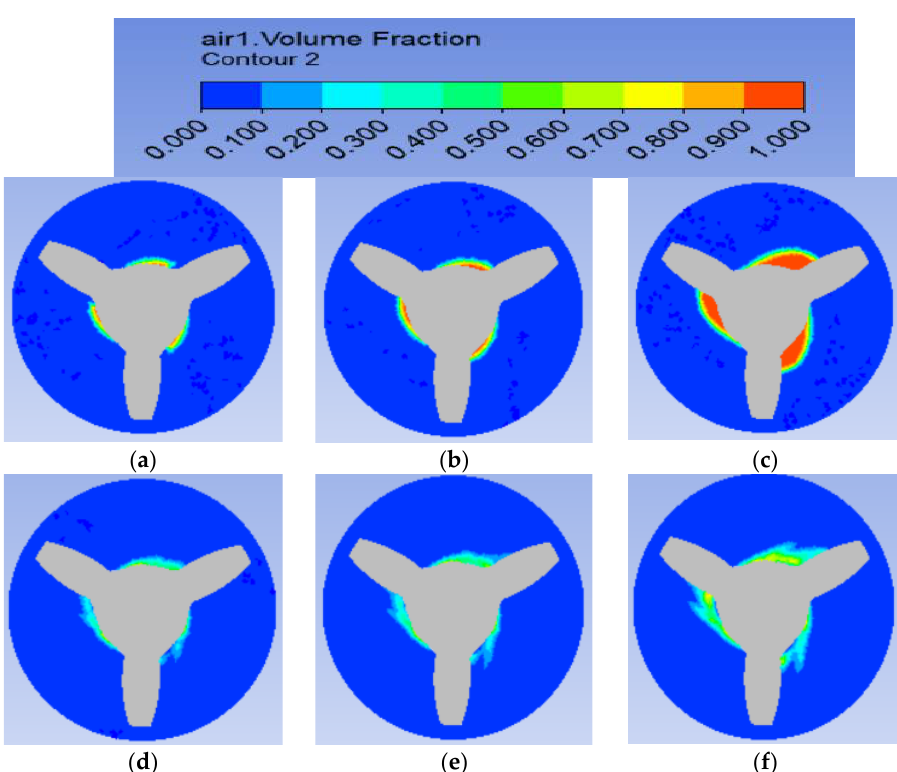
Figure 8. Cross-sectional cloud diagram of the liquid water vapor volume fraction of two different Zwart models at three temperatures. ( a ) Iso-Zwart T = 298 K; ( b ) Iso-Zwart T = 320 K; ( c ) Iso-Zwart T = 350 K; ( d ) Mod-Zwart T = 298 K; ( e ) Mod-Zwart T = 320 K; ( f ) Mod-Zwart T = 350 K.